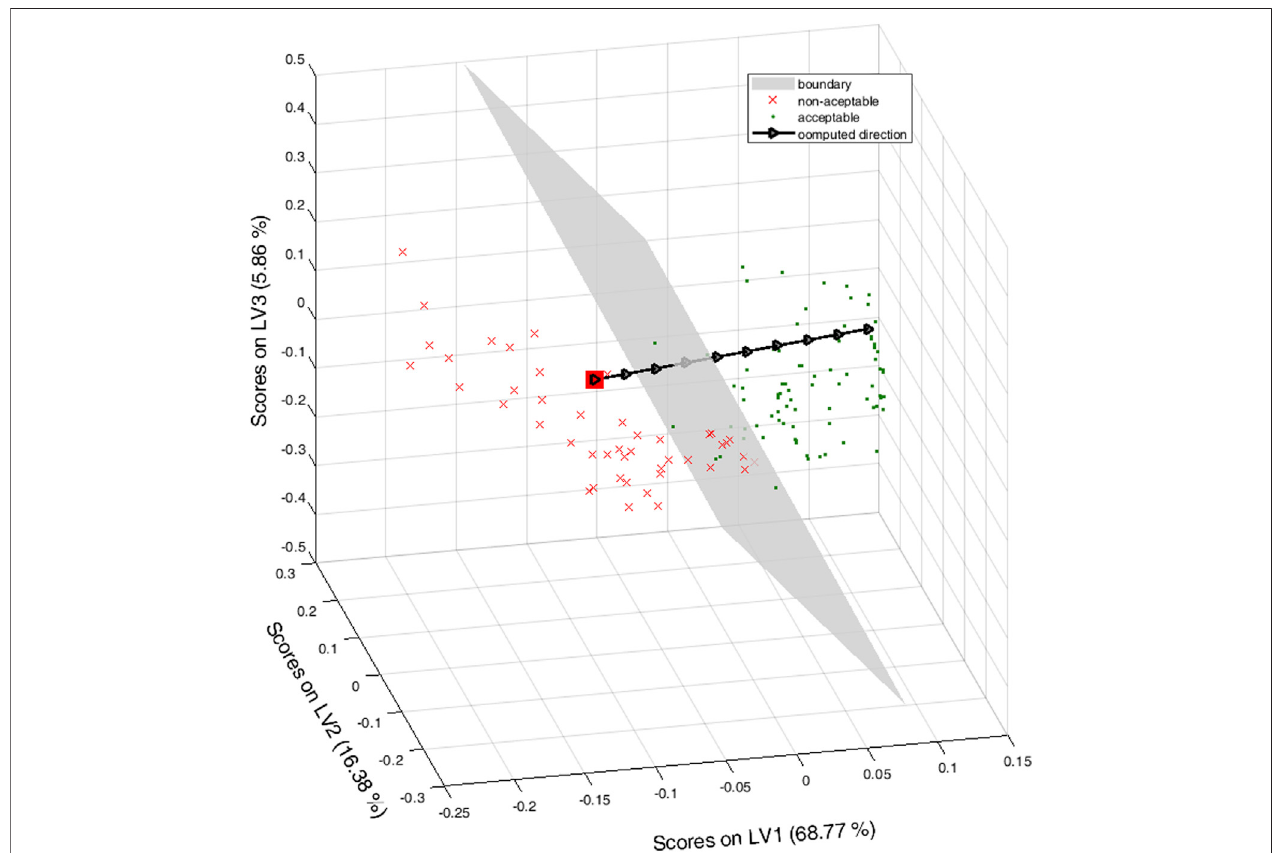
FIGURE3| Latent space fortheRioja wines.Green pointsare foracceptable wines,red crossesand thered fi lledsquare fornon-acceptable ones. Thegreyplane is the boundary plane for the class-model when sensitivity and speci fi city both equal to 0.954. The black triangles are along the direction of improving the color of the